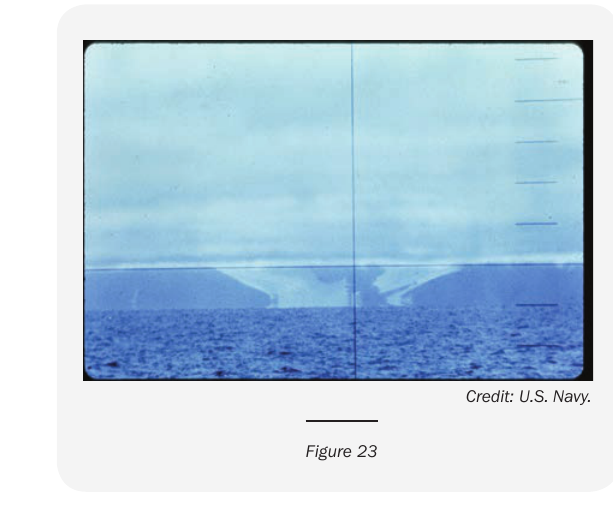
Credit: U.S. Navy.